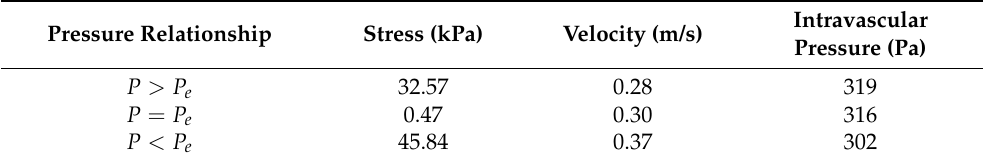
Table 2. Simulation parameters of vascular wall stress, blood flow velocity, and intravascular pressure under different pressure conditions.